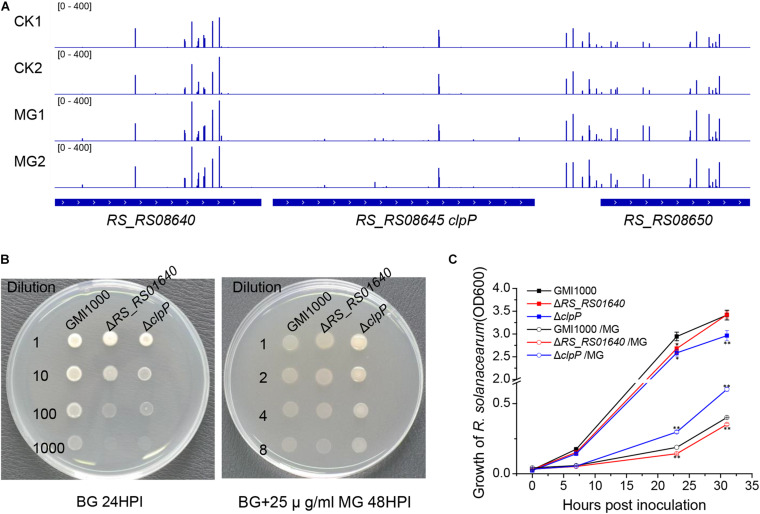
ClpP is necessary for the antibacterial activity of methyl gallate (MG) against R. solanacearum. (A) Transposon insertion distribution of clpP and its flanking sequence. (B) Gradient diluted bacterial cultures were inoculated on BG agar medium with or without 25 μg/ml of MG. The growth of R. solanacearum strains was observed and photographed at certain times. (C) Growth of R. solanacearum strains cultured in BG liquid medium with or with 25 μg/ml of MG. Growth differences between mutants and the wild-type strain GMI1000 with or without treatments at 23 and 31 h post inoculation are marked with asterisks, indicating P < 0.01 (**) or P < 0.05 (*), statistically analyzed by analysis of variance (ANOVA).